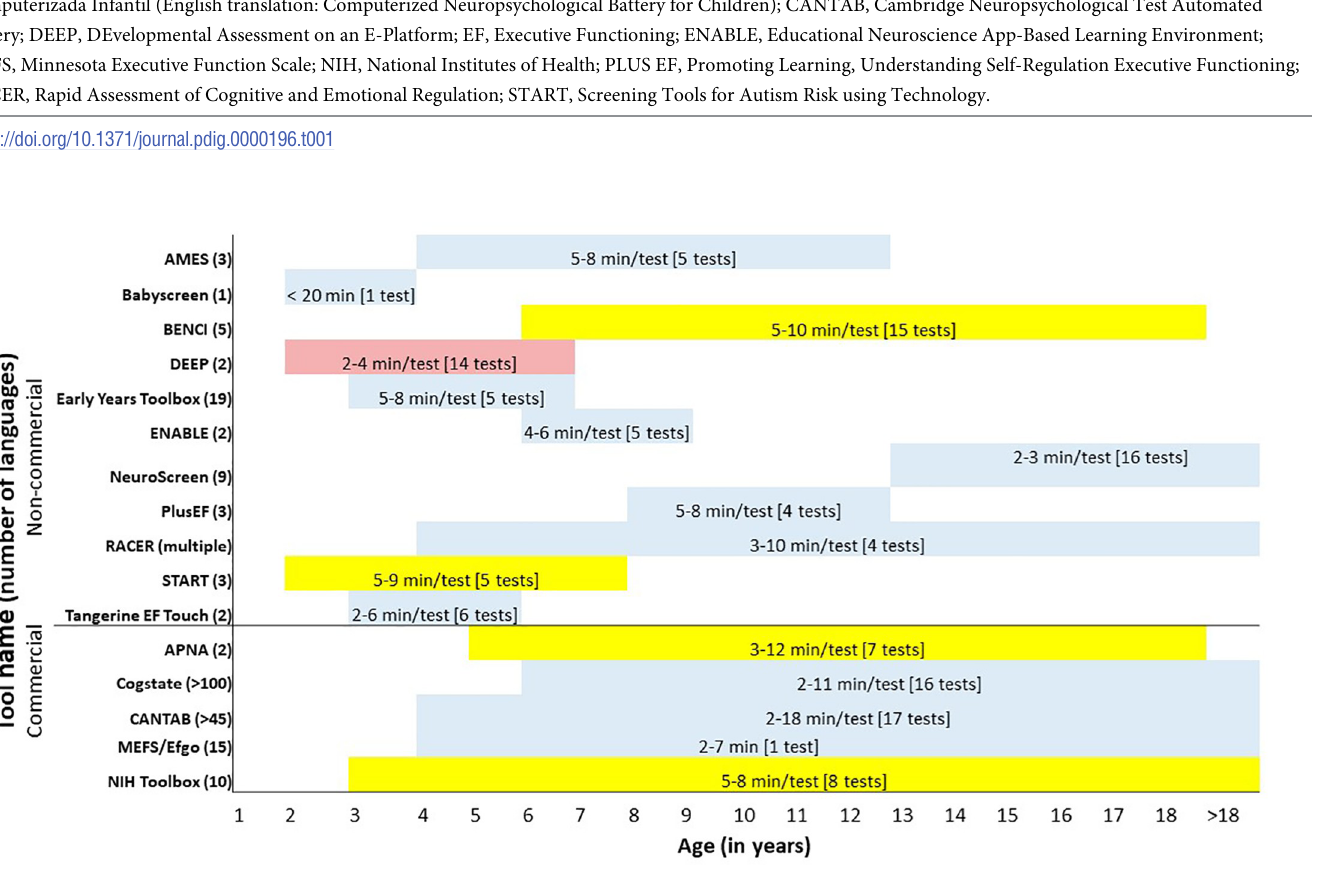
Fig 1. Synthesis across tablet-based cognitive assessments. The names of the tools are listed in the Y-axis, with non-commercial tools listed first, followed by commercial tools. The X-axis is the range of ages, in years, for the intended population for the tool’s use. The numbers encompassed by () by the tool names indicates the number of languages for which the tool is translated. The numbers within the bands indicate the number of minutes (min) required to complete each test, with the number of tests listed in []. The color of the bands indicates the amount of training required to administer, with blue indicating < 4 h of required training, yellow indicating an estimated 4–12 h of required training, pink indicating an estimated > 12 h of required